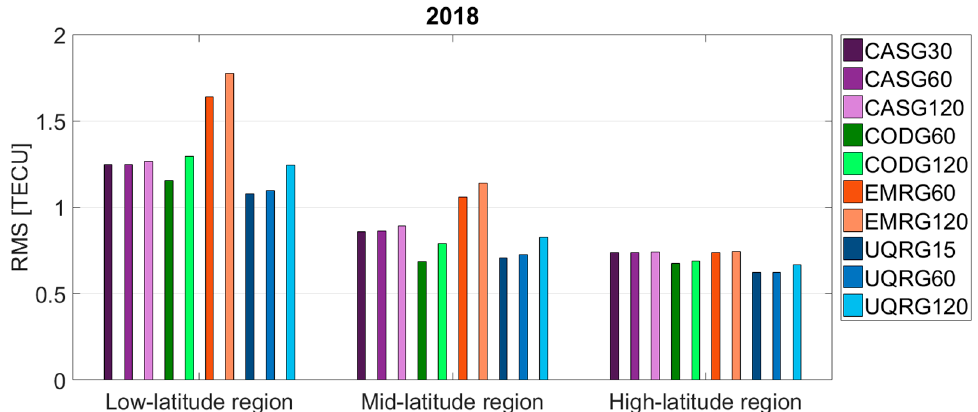
Figure 5. Annual RMS from GNSS-STEC comparisons for all analyzed GIMs over selected geomag- netic regions in 2018. Table 3. Annual STD from Alt-VTEC comparisons for all analyzed GIMs in 2018.